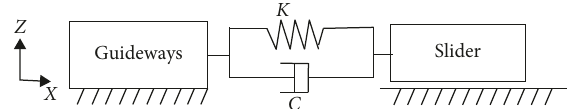
Figure 2: Simplified dynamic model of the hydrostatic